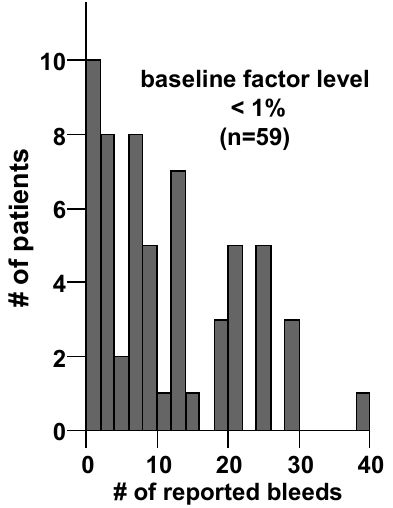
FIGURE 2. Variation in bleeding frequency among severe hemophilia A patients during a 6-month period . Histogram displaying broad range of bleeding episodes reported (on Universal Data Collection) by a cohort of 59 patients followed at Gulf States Hemophilia Treatment Center in Houston, TX. Each of these patients received only episodic (no prophylaxis) factor replacement. Data courtesy of Dr. W. Keith